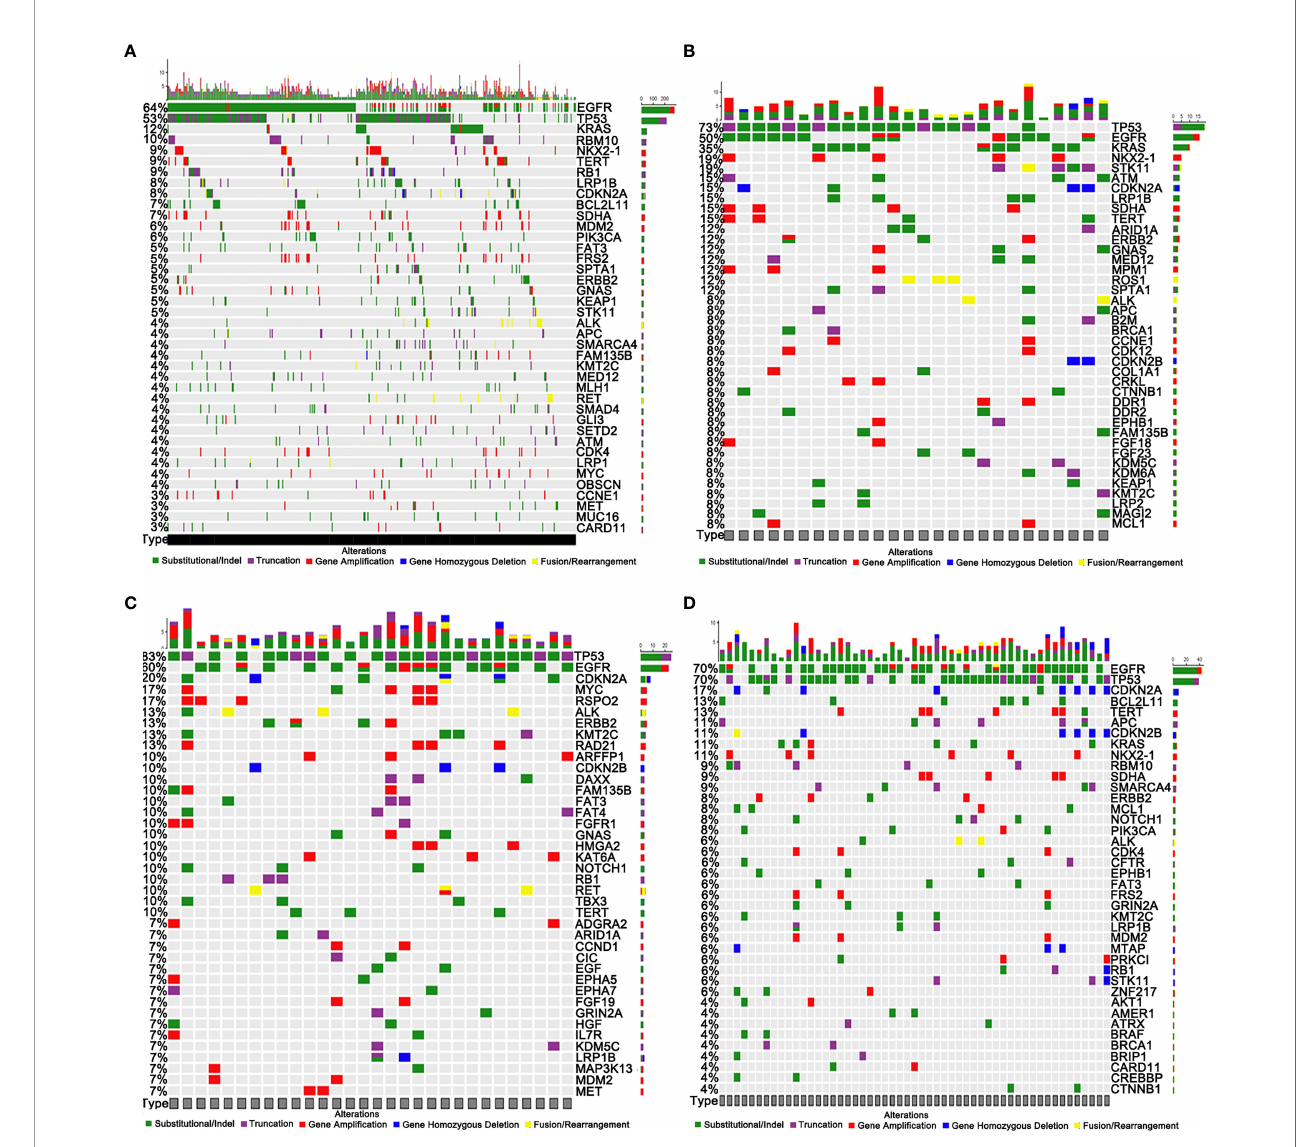
FIGURE 1 | Genomic pro fi ling of somatically altered genes and frequently mutated genes. (A) Primary tumors (PR). (B) Brain metastases (MT-brain). (C) Liver metastases (MT-liver). (D) Bone metastases